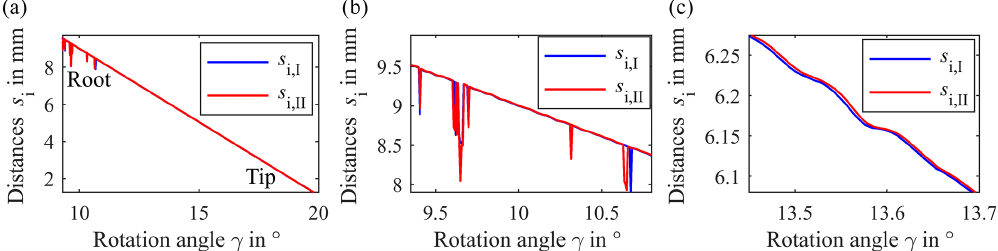
Figure 6. Measured distances s i, I and s i, II to the surface of the flank depending on the rotation angle (a) for one tooth, (b) for an enlarged image detail of (a) to illustrate the distance drops at the root of the flank and (c) for an enlarged image detail of (a) to illustrate the fluctuations of the distance